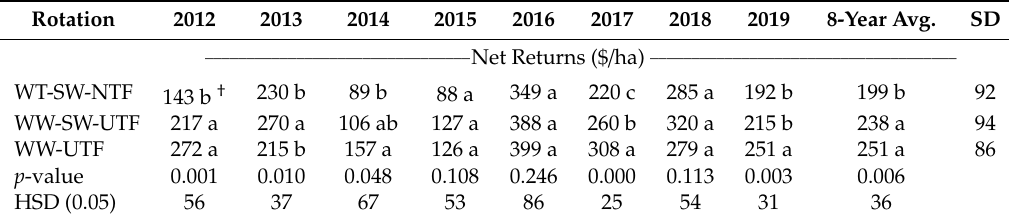
Table 8. Rotation average annual net returns, and average standard deviation over eight years (2012–2019) based on average crop prices.